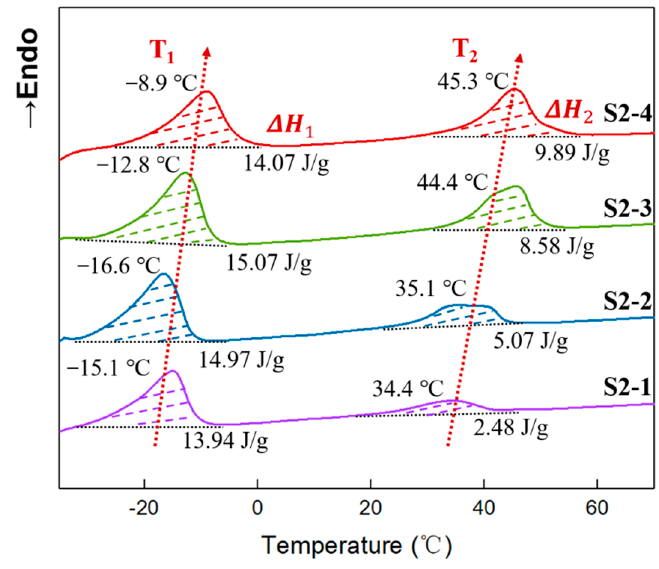
Figure 8. DSC curves of elastomers with different PEG contents.